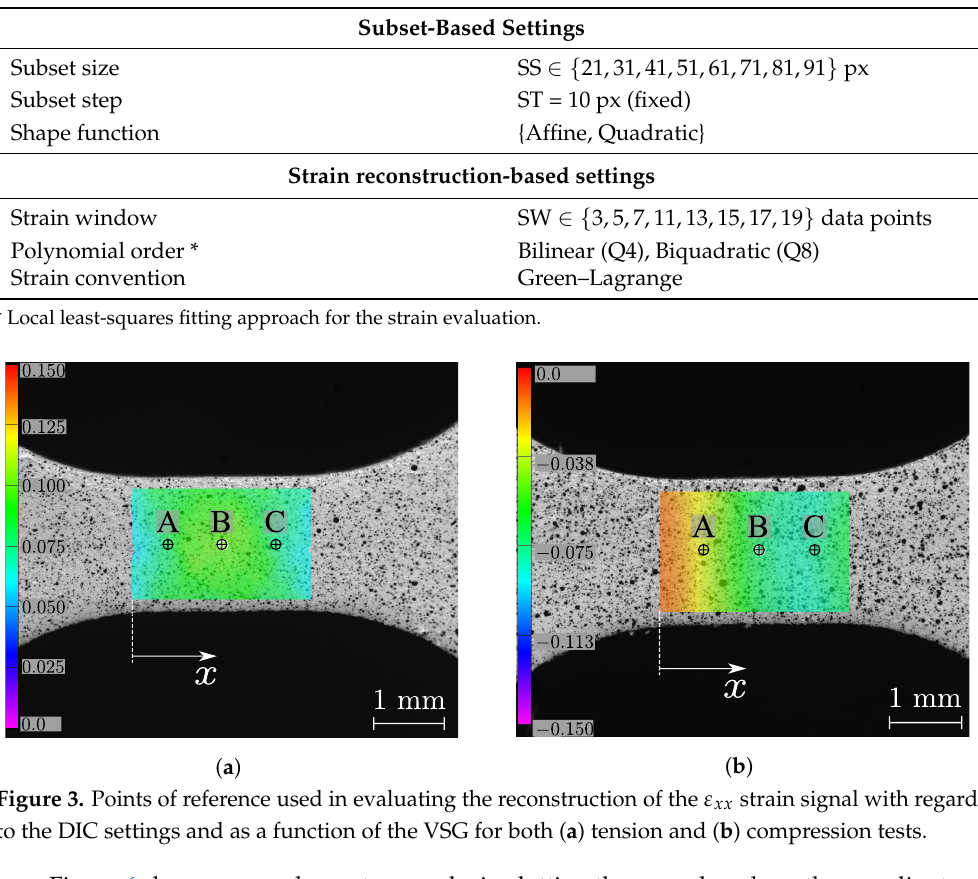
Table 4. Parameters used in the Performance Analysis Tool of MatchID 2D DIC.